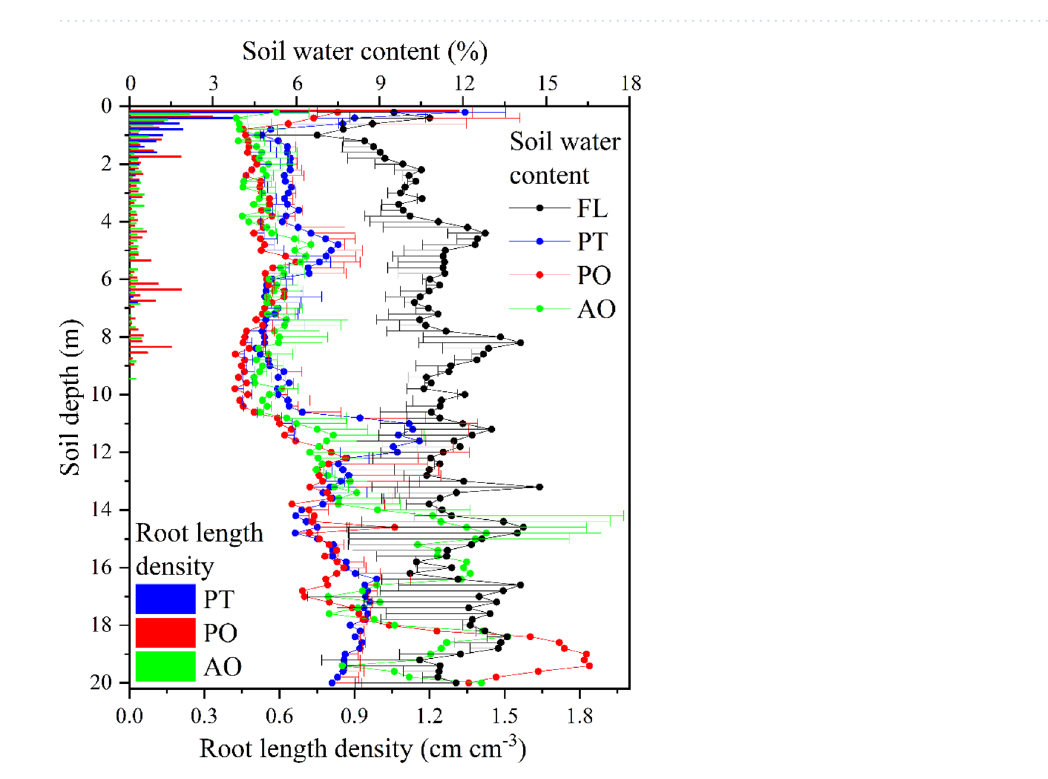
Figure 4. SOC storage ( a ), SIC storage ( b ) and SWS (c) in 0–20 m soil layer at all treatments. FL farmland, PO Platycladus orientalis (Linn.) Franco, PT Pinus tabulaeformis Carr., AO apple orchard. Bars are standard deviations.